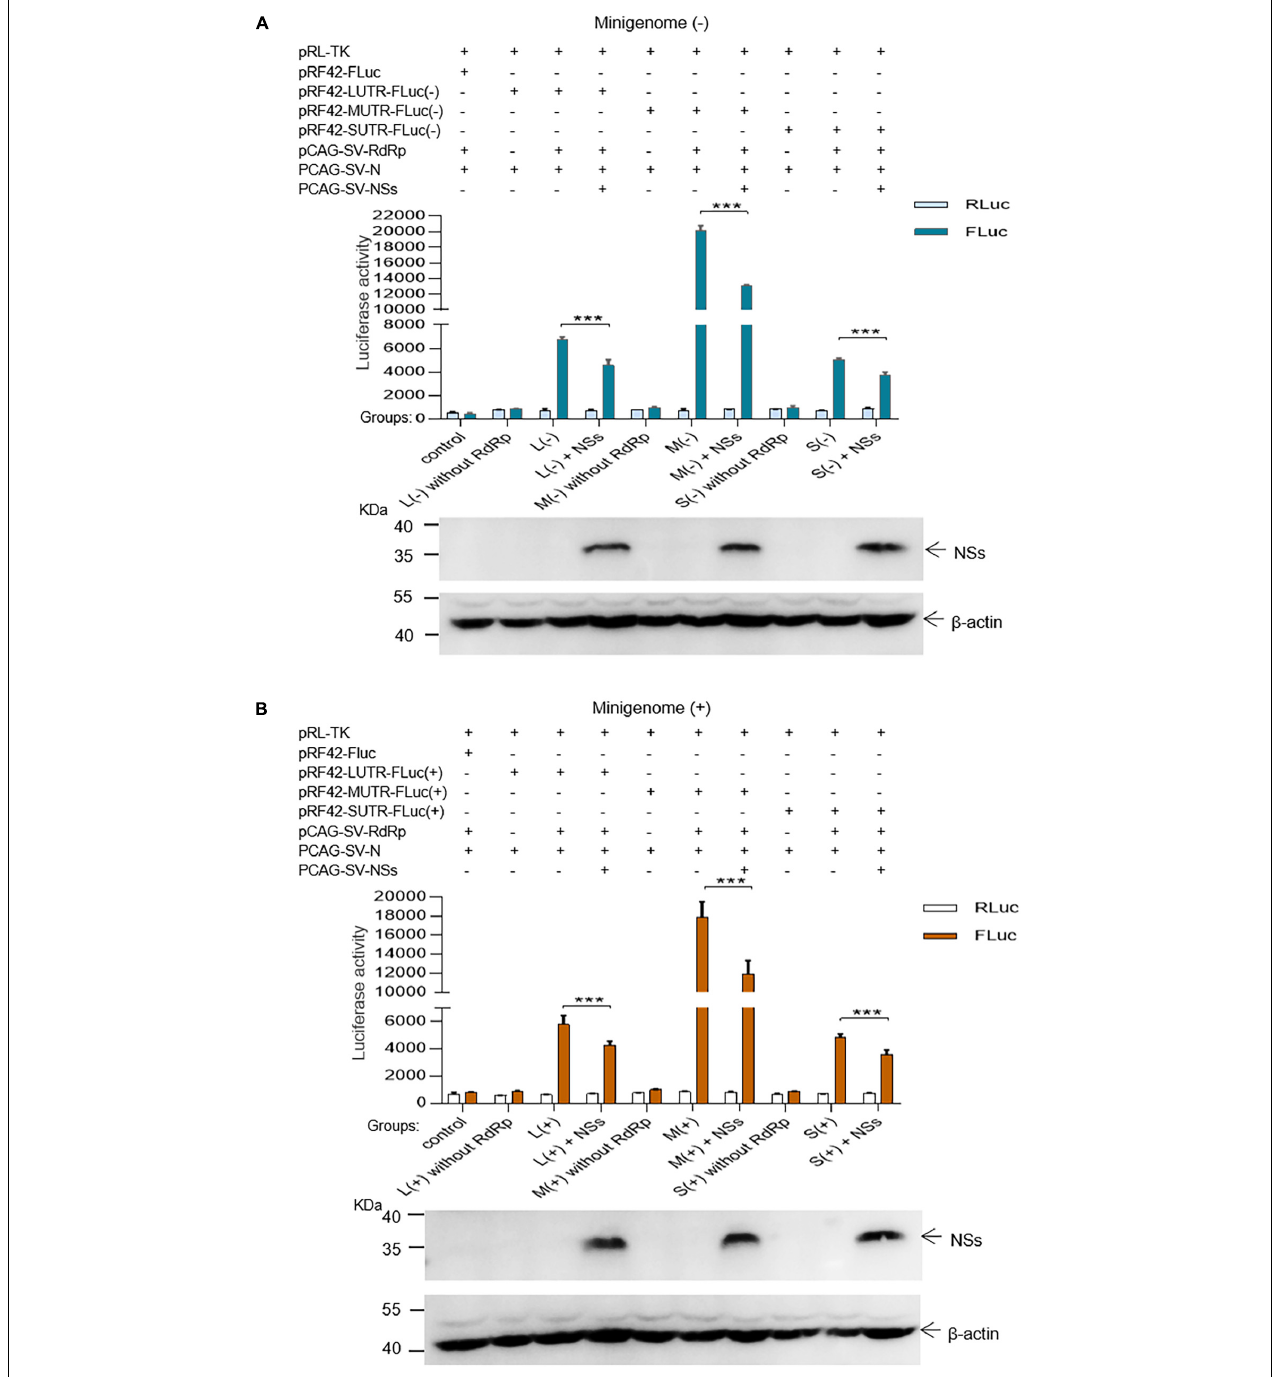
FIGURE 2 | SFTSV NSs decrease the minigenome (–)/(+)-encoded reporter activity. NSs downregulated reporter activity within the minigenome (–) and minigenome (+) systems based on viral L, M, and S denoted as L (–)/(+), M (–)/(+), and S (–)/(+), respectively. Briefly, groups of various plasmid mixes indicated in (A,B) were transfected into BHK-21 cells cultured in 12-well plates with Lipo 3000, respectively. The symbol “+” means the presence of designated plasmid in plasmid mixes and “–” means the absence of designated plasmid in plasmid mixes. Cells were transfected with 1.0 µ g of minigenome (+)/(–) plasmids or control plasmids pRF42-FLuc, 0.5 µ g RdRp, N, and NSs expression plasmids, along with 10 ng of internal control plasmid pRL-TK to express Renilla luciferase. Meanwhile, negative control groups including L (–)/M (–)/S (–) without RdRp and L (+)/M (+)/S (+) without RdRp were independently set up to check that the integrity of the minigenome system is important for virus-like RNA synthesis in both minigenome (–) and minigenome (+) systems. At 48 hpt, firefly luciferase and Renilla luciferase were measured by using Dual-Glo Luciferase Assay System kit as the technical manual and data are presented as the mean ± standard error of mean (SEM), n = 3. *** p < 0.001 (A,B) . Meanwhile, the NSs expression levels were analyzed by Western blotting by using β -actin as internal control (A,B) .